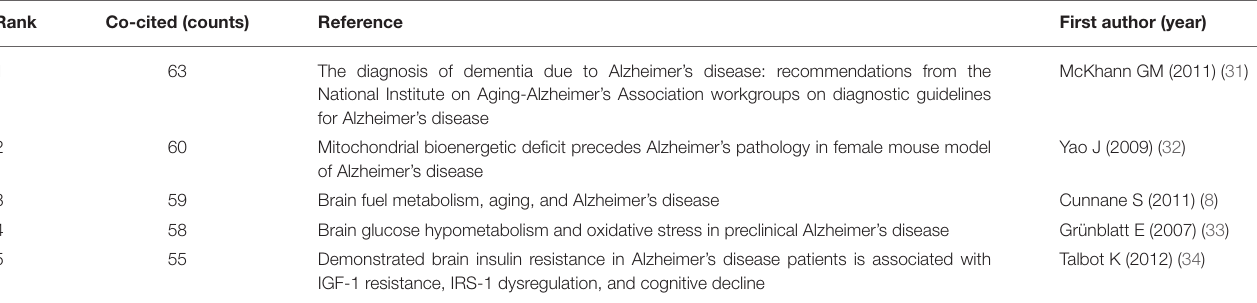
TABLE 6 | Top five co-cited references.